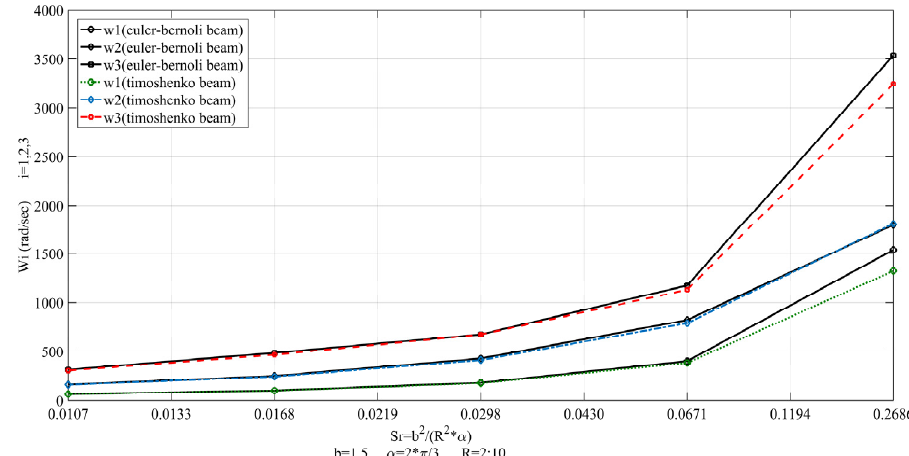
Figure 12. Natural frequencies of Timoshenko and Euler-Bernoulli curved beam with the S-S condition versus the slender coefficient